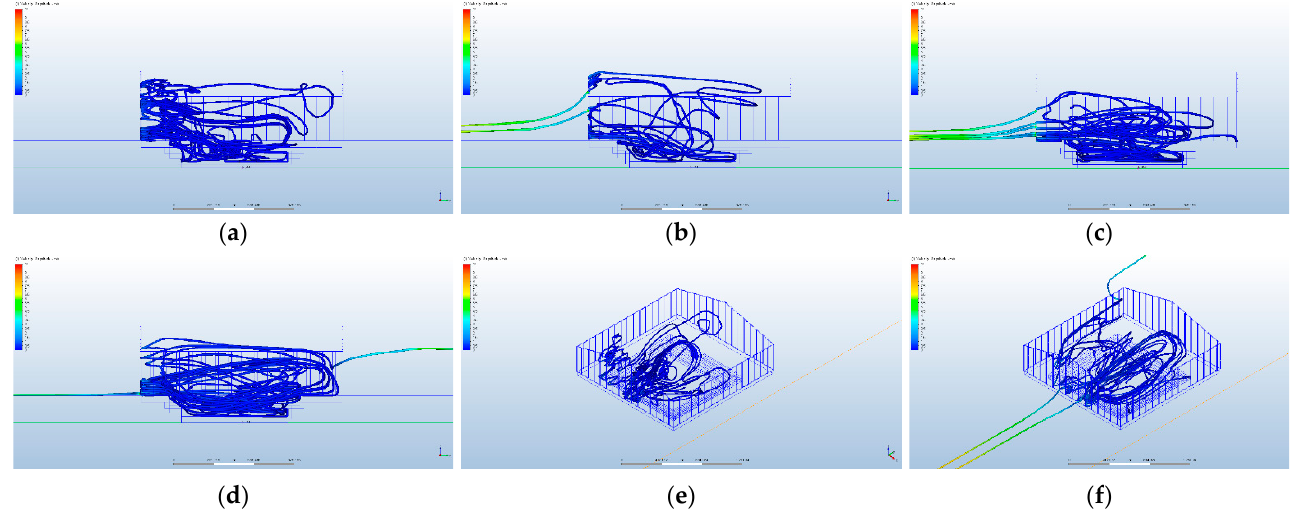
Figure 13. Airflow traces in the pit when the smoke hole is closed. ( a ) 1 cm gap; ( b ) 2 cm gap; ( c ) 3 cm gap; ( d ) 4 cm gap; ( e ) Axonometry corresponding to ( a ); ( f ) Axonometry corresponding to ( d ) (Autodesk CFD ®